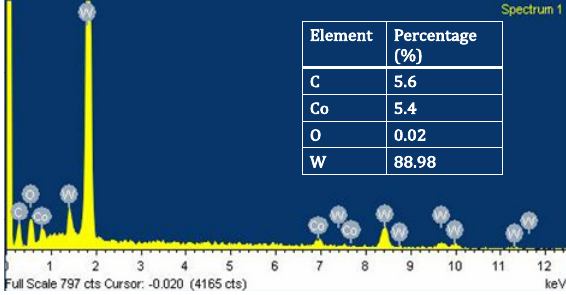
Figure 1. EDXA showing composition of WC-Co composite Five-axis Ecocut (ELPLUS-15) CNC WEDM is used for the experimentation purpose. In this work, four WEDM process parameters such as wire feed (3-12m /min), servo voltage (35-65V), pulse off-time (20-40 μ